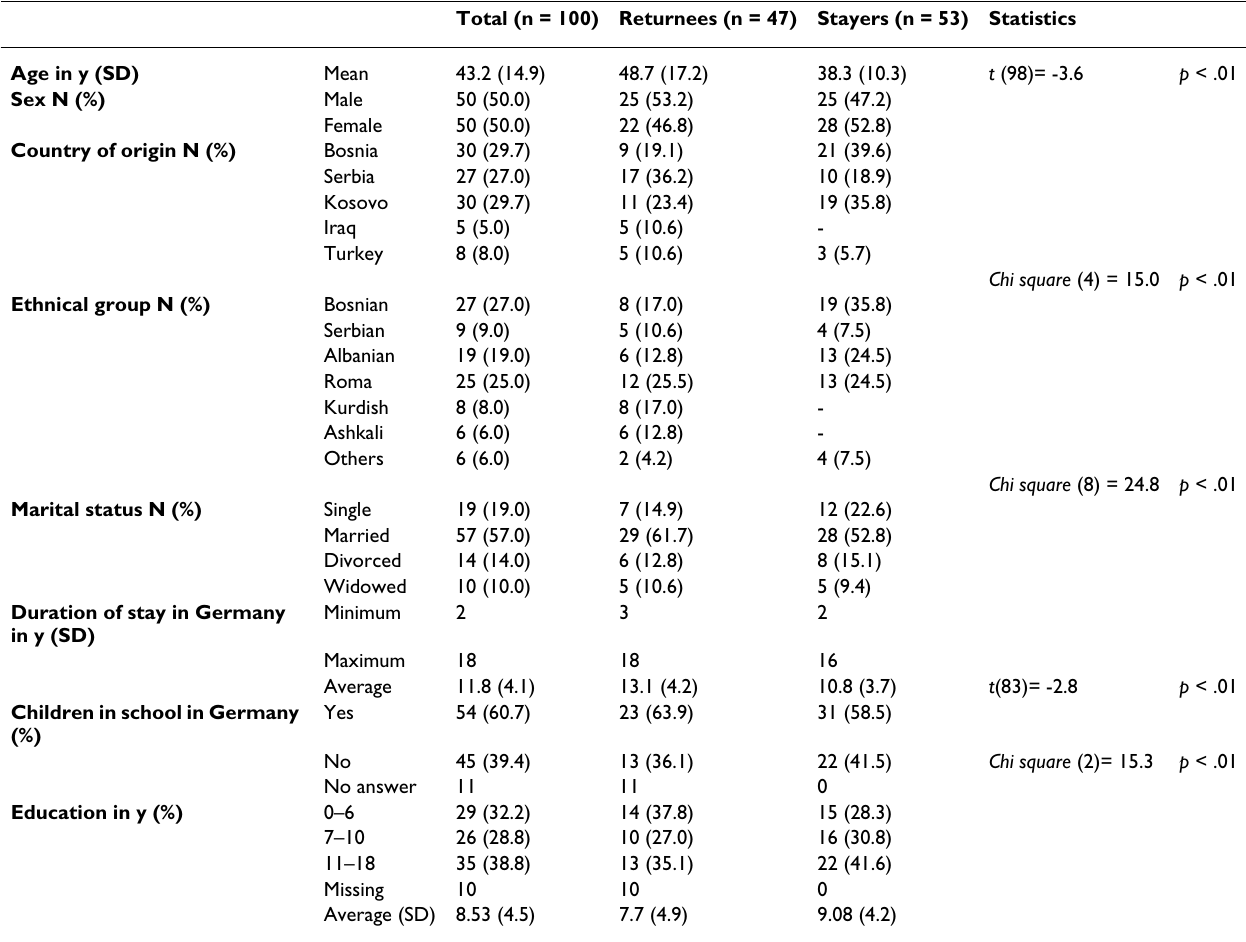
Table 1: Demographic